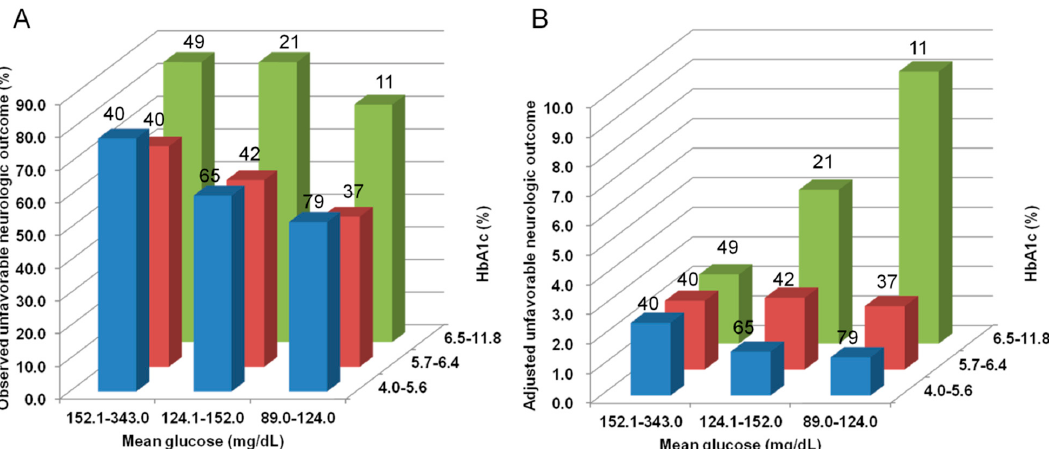
Figure 3. Outcomes according to estimated average glucose (EAG) or standard groups. ( A ) The EAG group had significantly lower unfavorable neurologic outcomes ( p = 0.001), lower serum neuron-specific enolase ( p = 0.001), and higher incidence of hypoglycemia ( p = 0.006) in the entire cohort. ( B ) The EAG group showed similar neurologic outcomes ( p = 0.728) to the standard group and had a neuron-specific enolase level ( p = 0.501) comparable to the standard group, and higher incidence of hypoglycemia ( p = 0.004). * Number of patients included in the analysis.